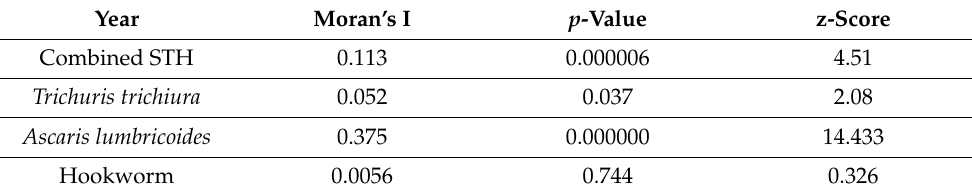
Table 2. Moran’s index computed for each STH species and for and combined STH incidence rates at the HFSA